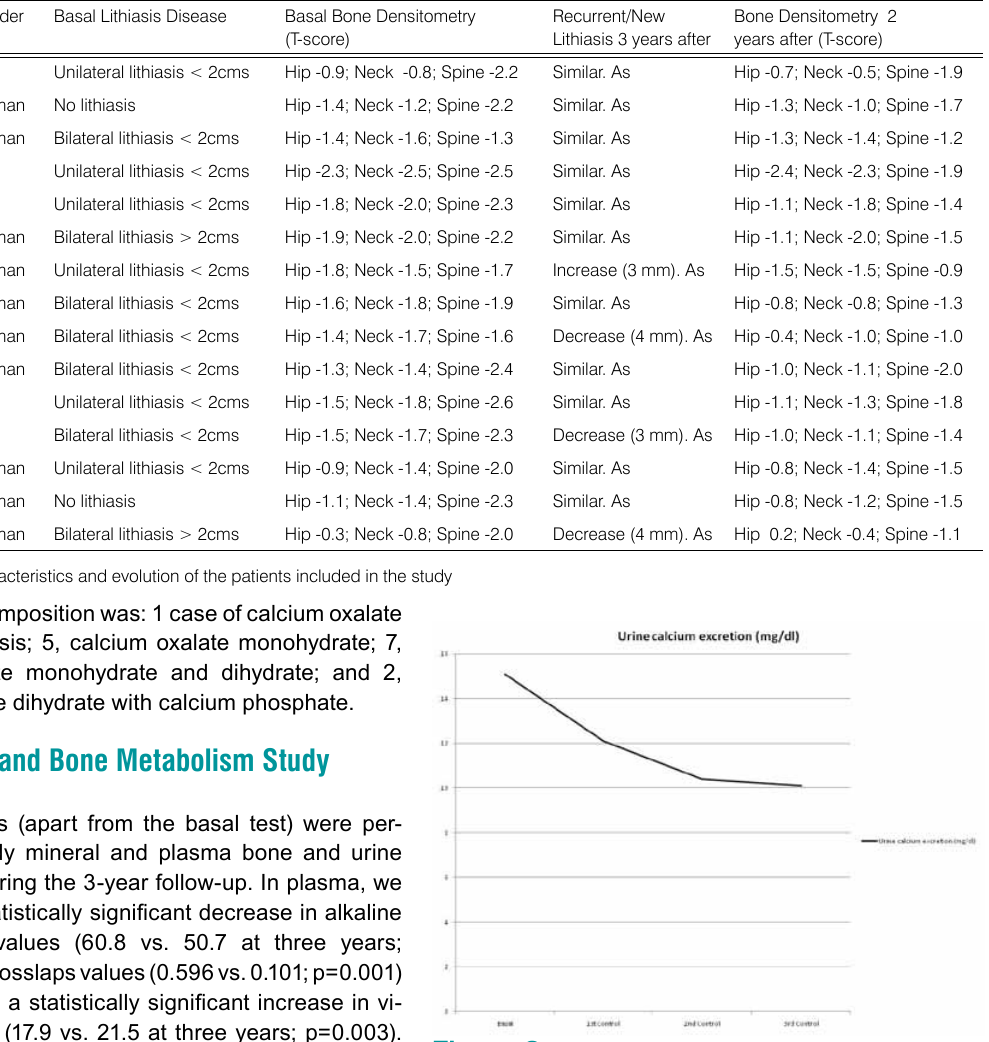
Figure 2. Evolution of urinary calcium levels after 3 years of treat- ment with alendronate